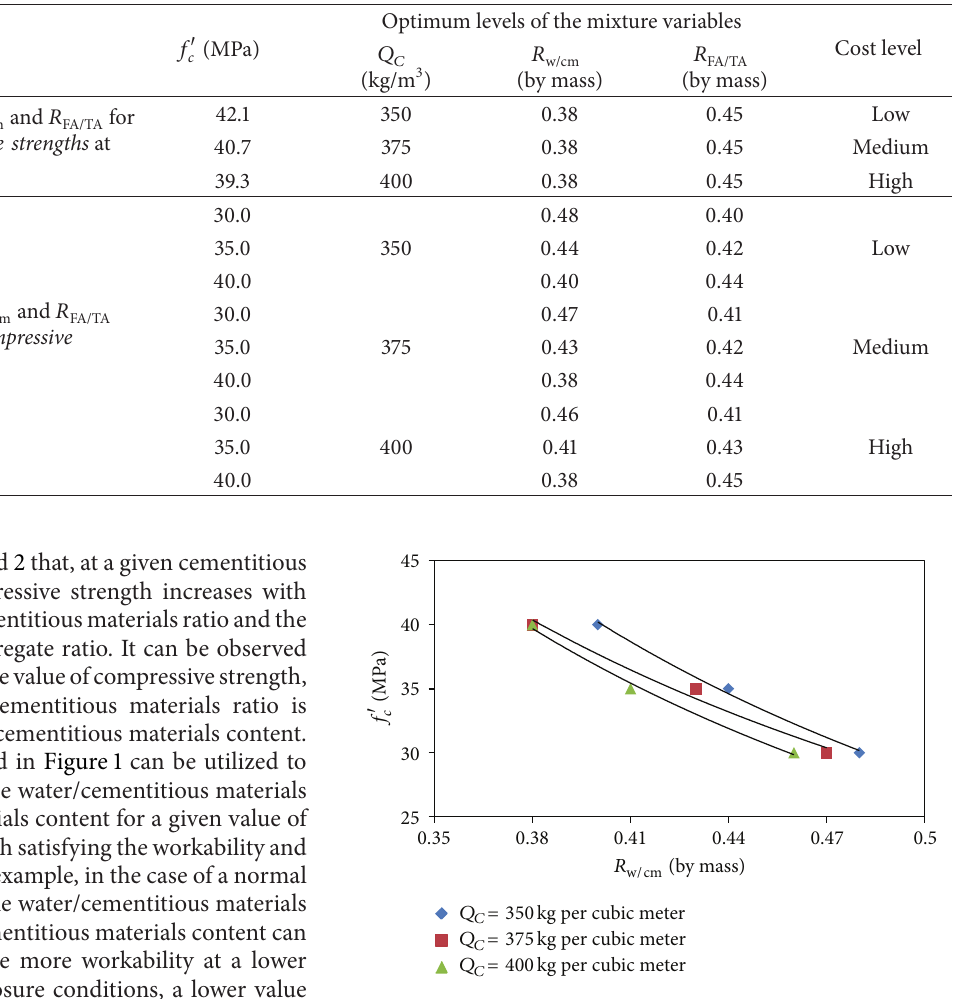
Figure 1: Variation of compressive strength with 𝑅 levels of 𝑄 𝐶 .